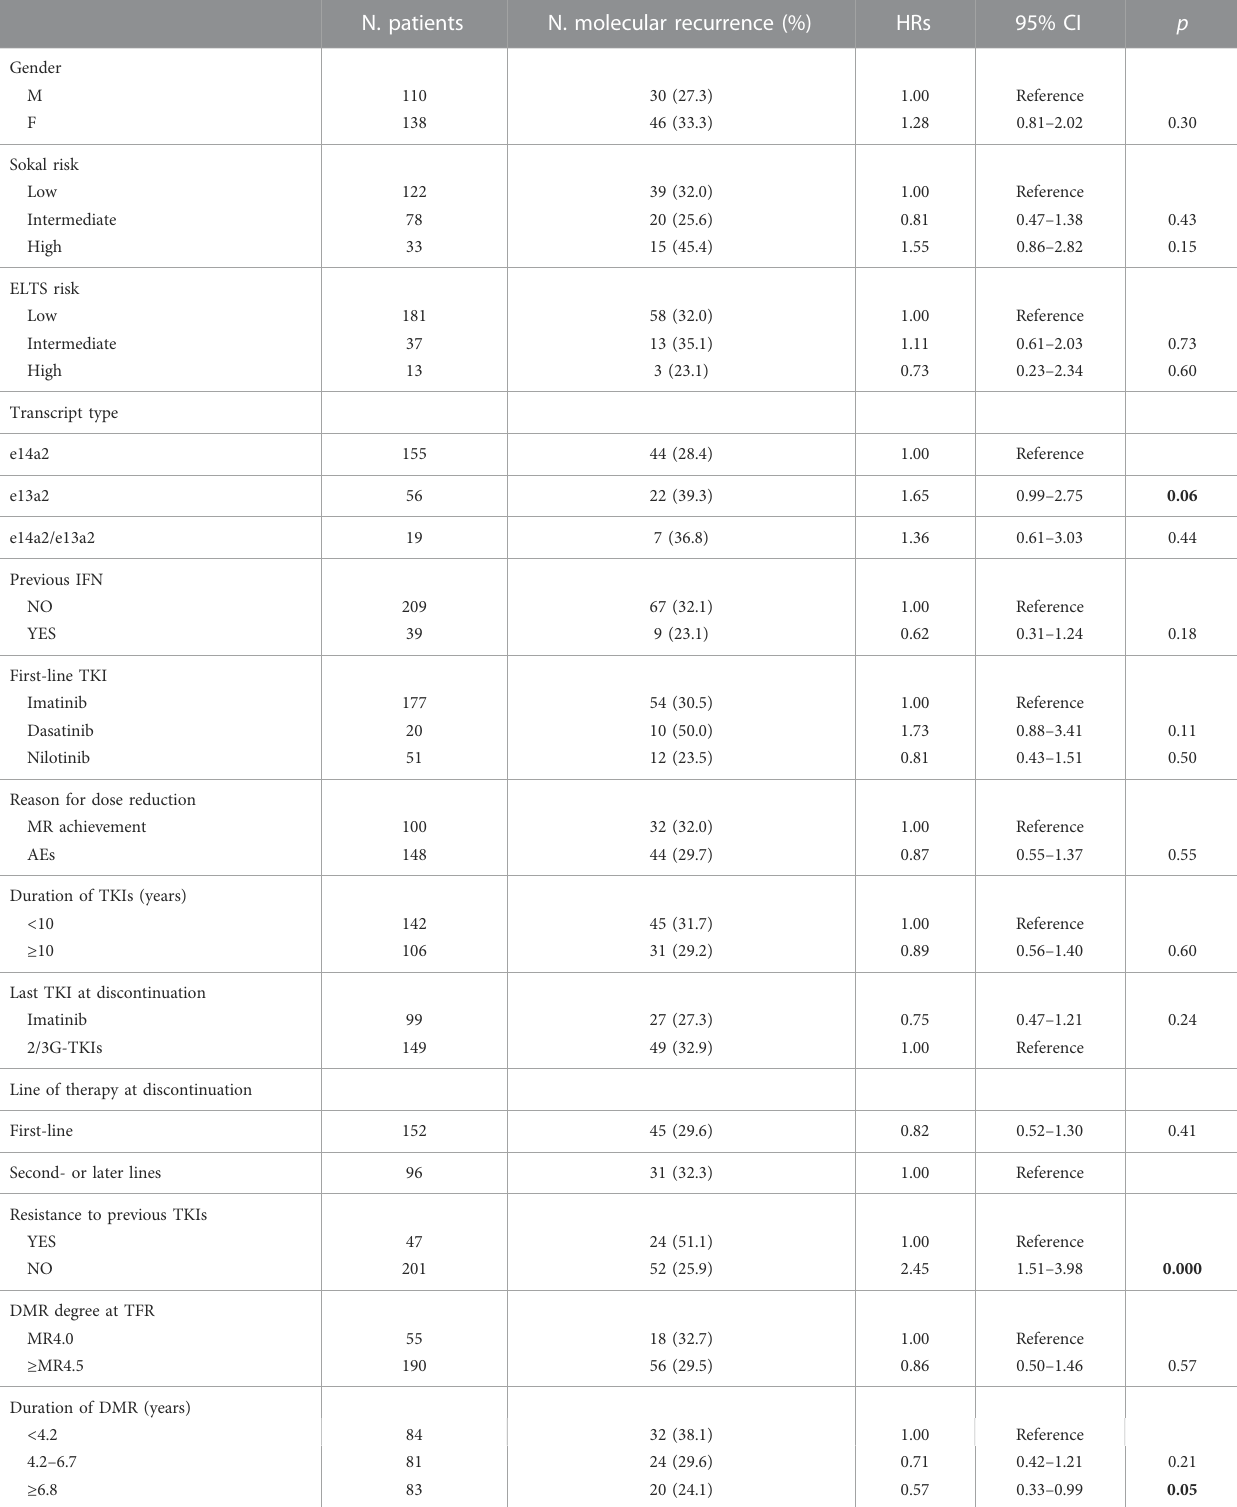
TABLE 2 Molecular recurrence risk and hazard ratios from univariate Cox models according to selected